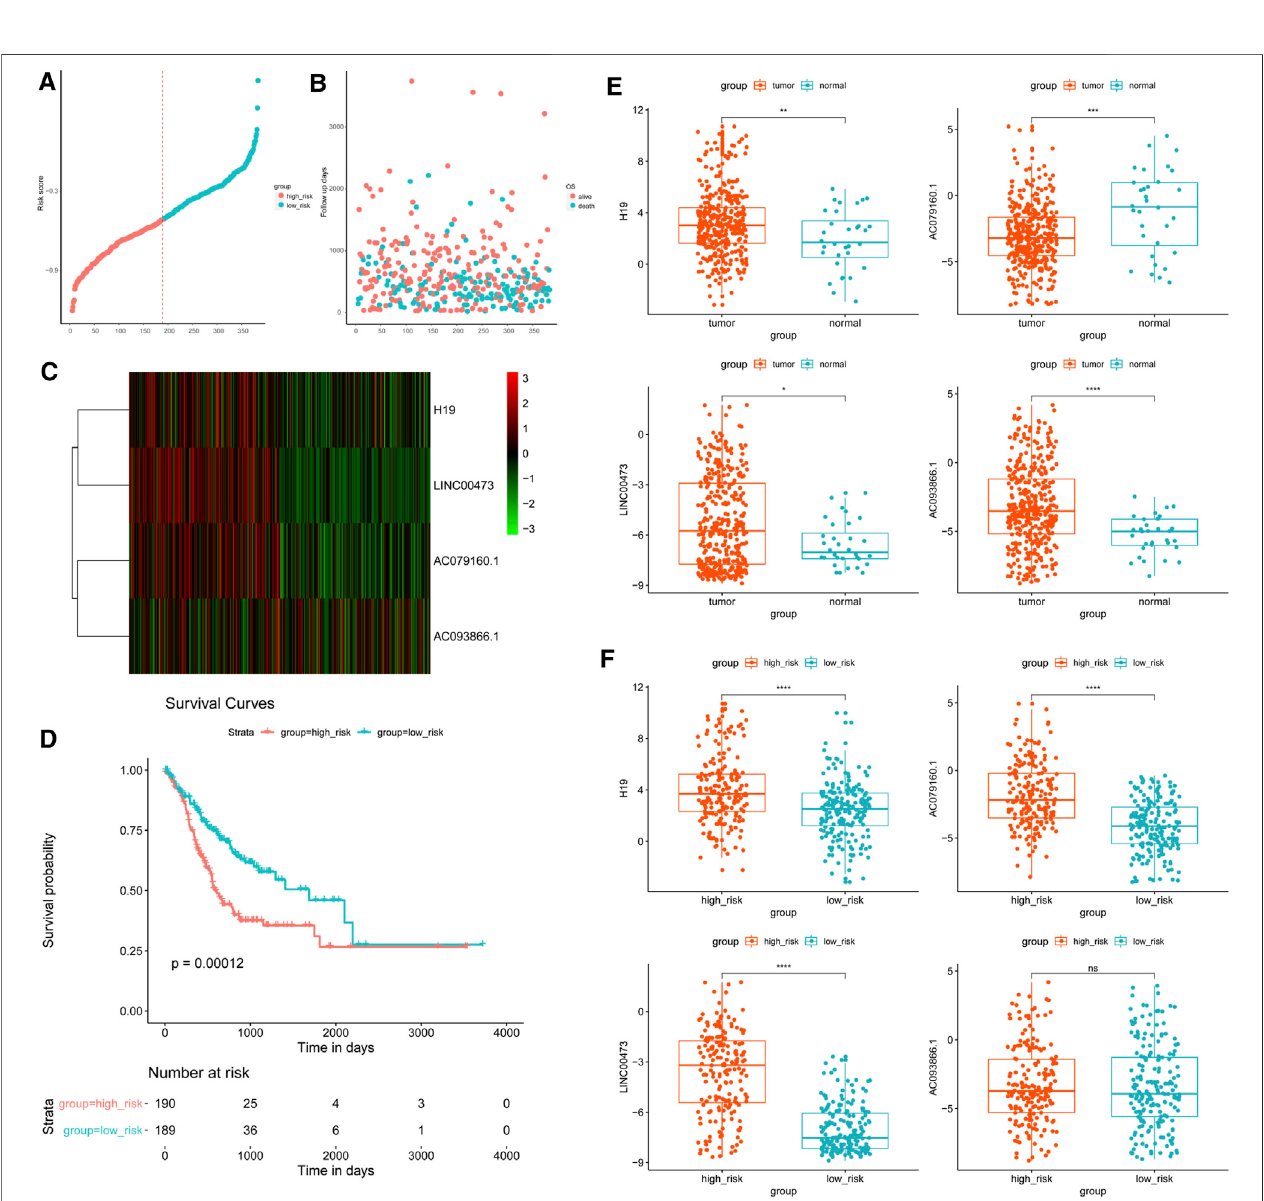
FIGURE5| RiskscoreinvestigationofthedifferentiallyexpressedlongnoncodingRNA(lncRNA)signatureingastriccancer.Ariskscoreisshownaccordingtothe survival status and disease duration of the GC patients. (A) The abscissa refers to sample number and the ordinate depicts the risk score value. (B) GC patients were categorizedintolow-riskandhigh-riskgroupsbasedonthemedianin fl ectionpointoftheriskscorecurve,whichisrepresentedbythedottedline. (C) lncRNAexpression of low- and high-risk score patients. Colors from green to red indicate low to high lncRNA expression. (D) Overall survival (OS) status according to Kaplan – Meier analysisoftheriskscore. (E,F) ExpressionoftheselectedlncRNAsin (E) tumorvs.controlsamples,and (F) high-vs.low-riskpatients.* p < 0.05,** p < 0.01,*** p < 0.001, **** p < 0.0001. NS, non-signi fi cant.